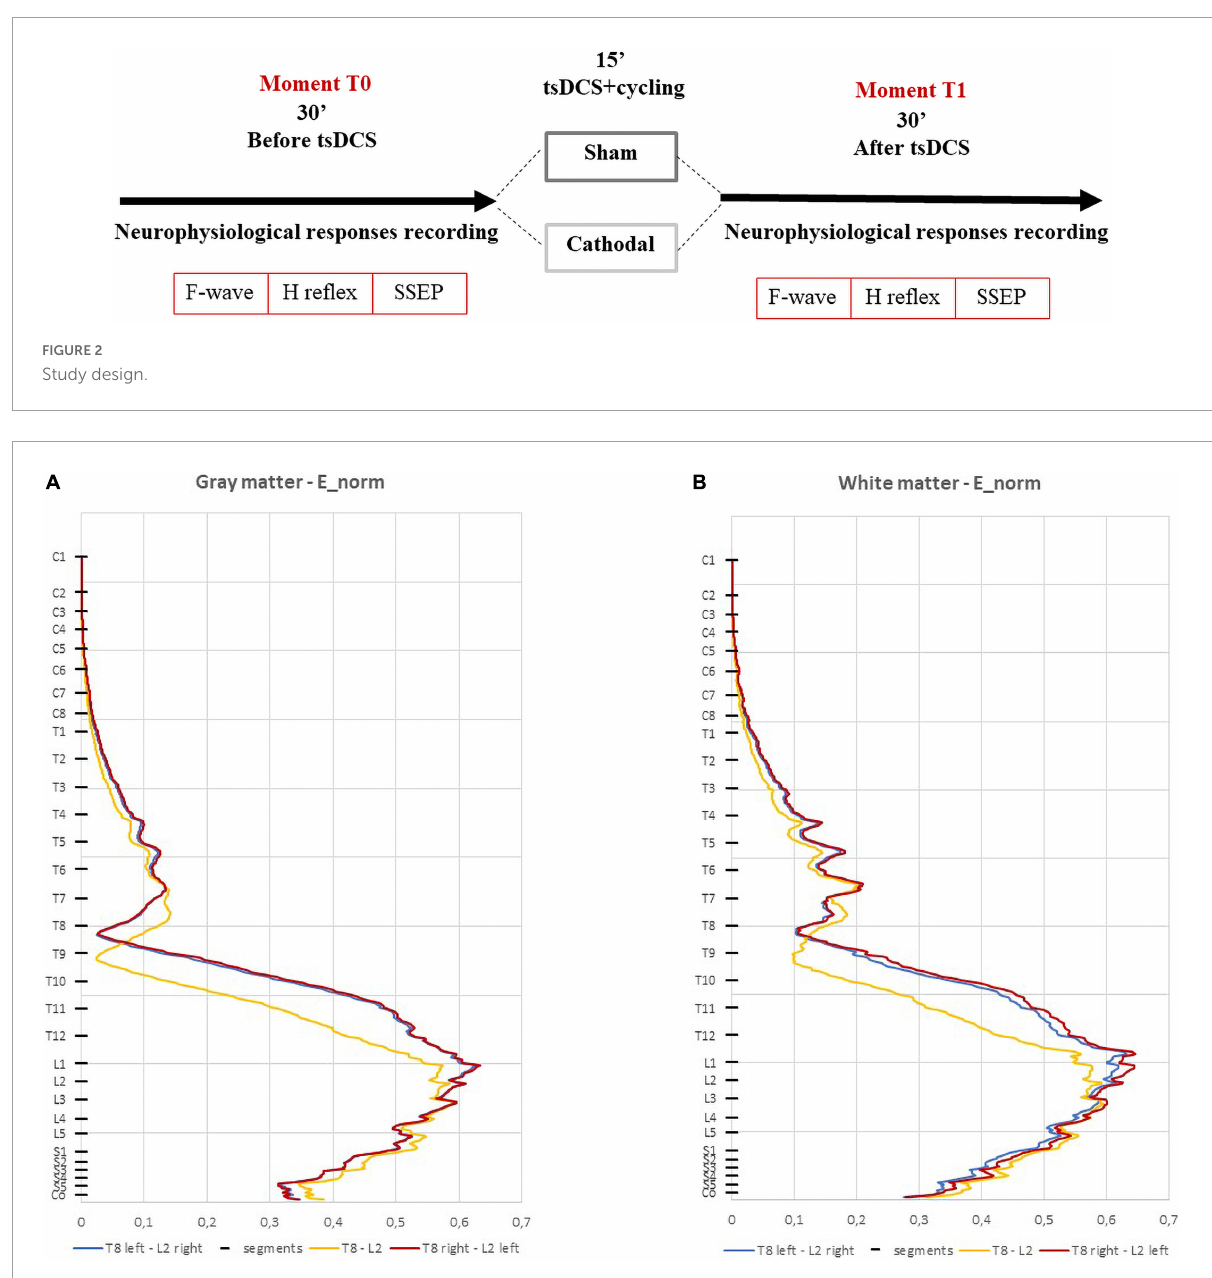
FIGURE3 Average electric field (E-field) magnitude in the spinal cord (SC) (V/m) in 1 mm thick transverse slices along the z direction in the three montages: (A) spinal gray matter (spinal-GM); (B) spinal white matter (spinal-WM). The positions of the spinal segments along the SC are indicated in the vertical